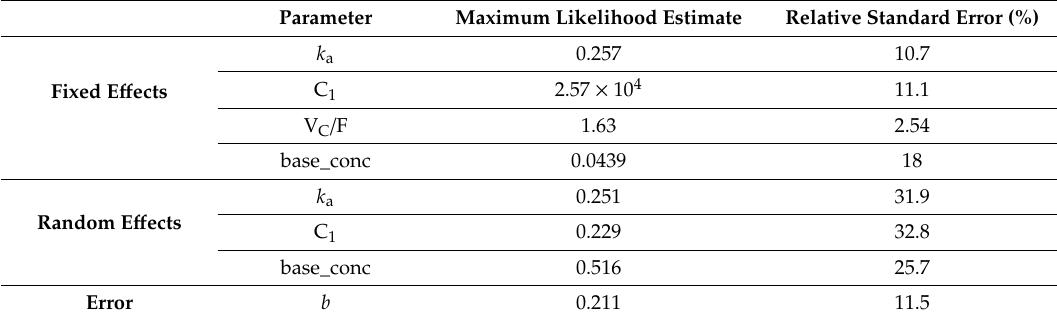
Figure 3. Identity (observations vs. predictions) plots for serum estradiol-17 β concentrations on logarithmic axes. The left panel is the population predictions (fixed e ff ects), and the right panel is the individual predictions (fixed and random e ff ects). The solid line is the line of identity (y = x). This model uses proportional residual error. Table 2. Parameter estimates from the nonlinear mixed-e ff ects (NLME)